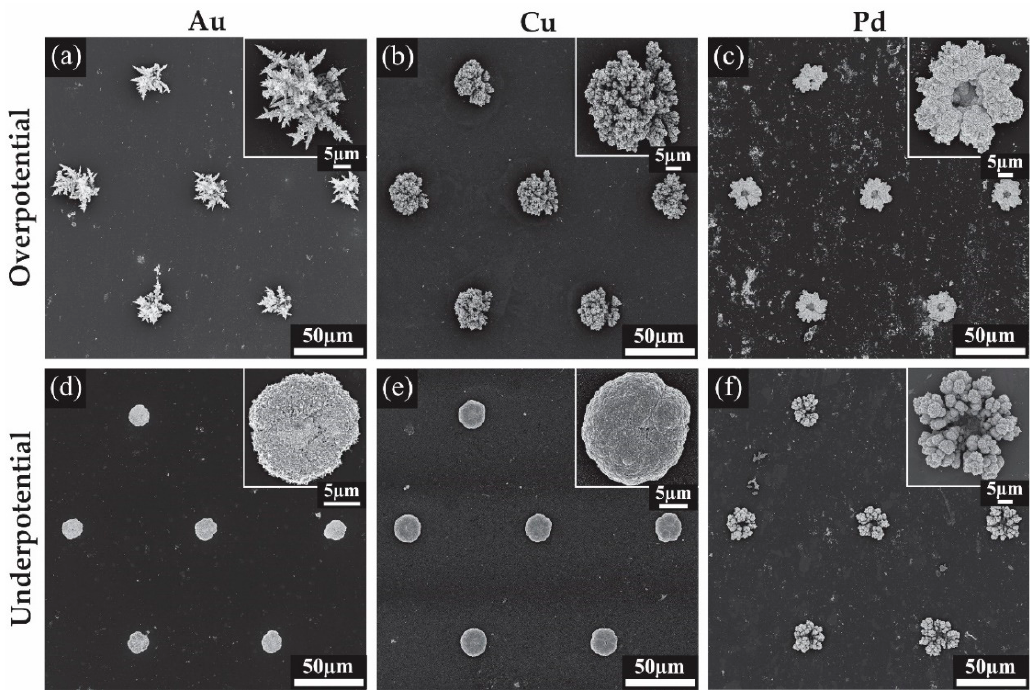
Figure 4. Scanning electron microscopy (SEM) images for the 3-dimensional structures formed on Pt MATFEs using Au, Cu and Pd with insets of a magnified single structure. ( a ) Au at 0.1 V, ( b ) Cu at − 0.4 V, ( c ) Pd at 0.1 V, ( d ) Au at 0.5 V, ( e ) Cu at − 0.2 V, ( f ) Pd at 0.35 V.